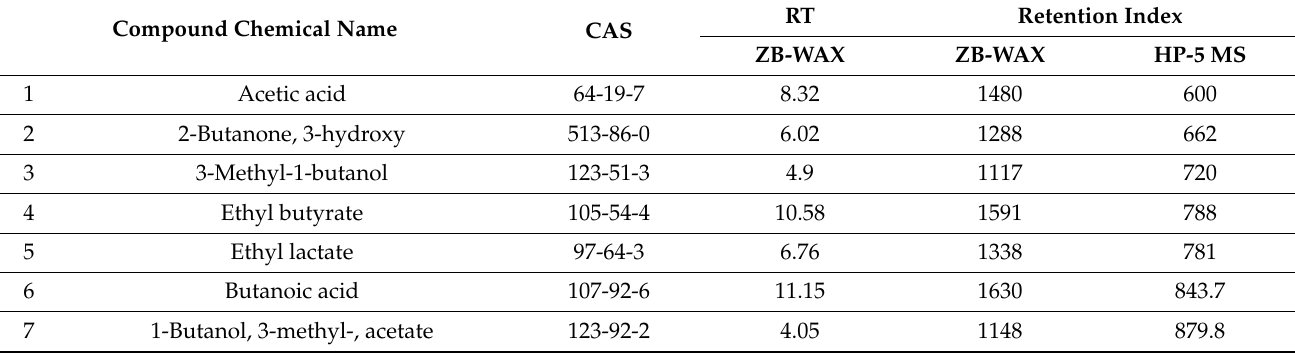
Table 3. Compounds that are electrophysiologically active from all eluted mixtures, RT- retention time for compounds eluted on the polar column, retention index from the polar and non-polar